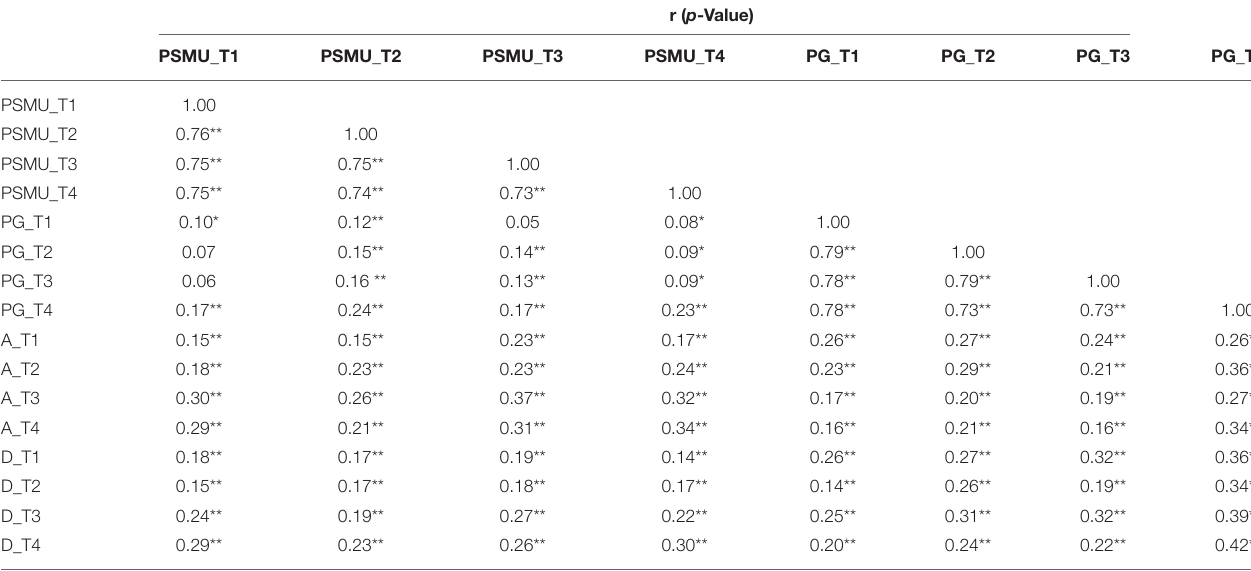
TABLE 3 | Correlation between problematic social media use, problematic gaming, and psychological distress (anxiety and depression).